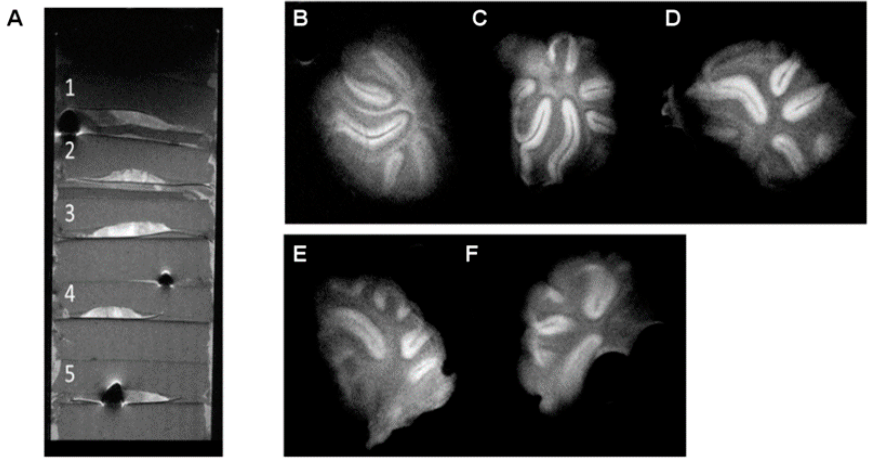
Figure 3. MR imaging of thick organotypic cultures: ( A ) sagittal MR image of five mouse cerebellum organotypic cultures stacked in agar (sagittal MR image); ( B – F ) coronal MRI 2D images (300 µm slice thickness) of the organotypic slices. The white matter–gray matter limit blurred as the cultured tissues evolved.